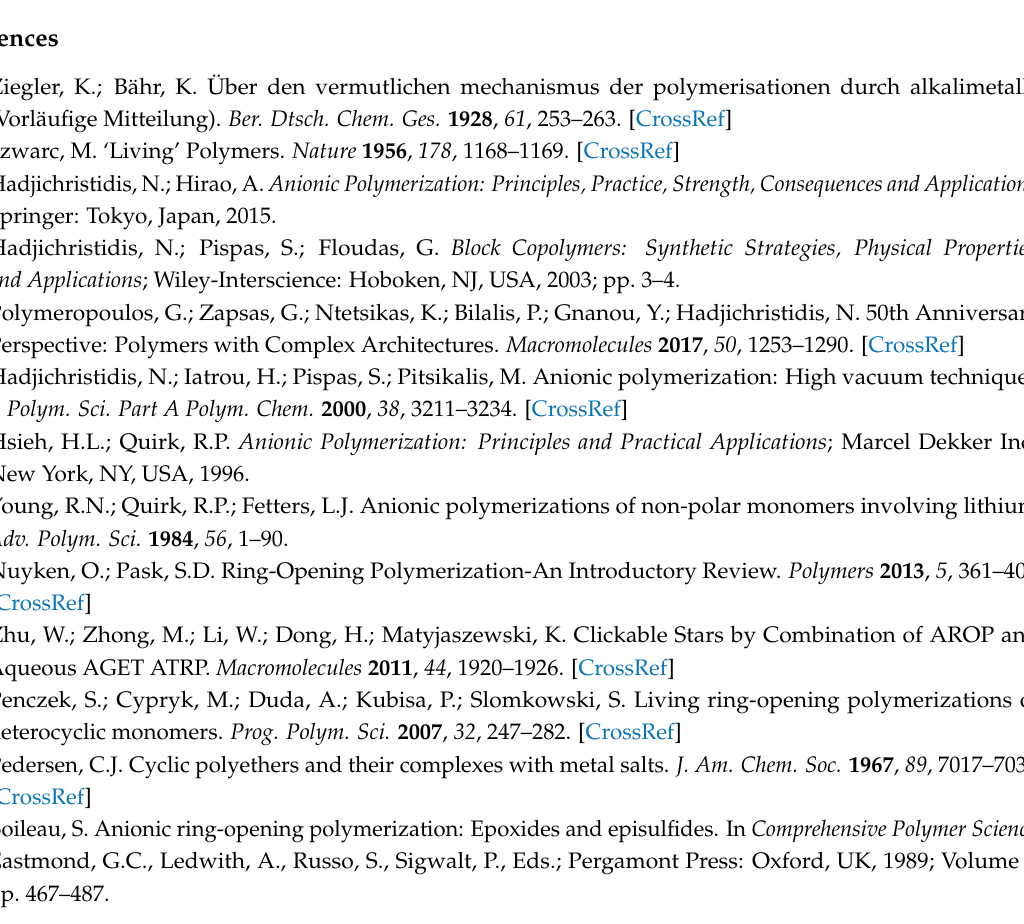
Figure S1: SEC traces obtained from withdrawn aliquots at 10 min and 20 min {[ t -BuP 4 ]/[ sec -BuLi]:1/1, styrene}; Figure S2: 1 H-NMR spectra after 30 min, 2 h and 4 h (100% conversion) {[ t -BuP 2 ]/[ sec -BuLi]:0.5/1, styrene}; Figure S3: SEC traces obtained from withdrawn aliquots during the polymerization of styrene with [ t -BuP 2 ]/[ sec -BuLi]:0.5/1; Figure S4: SEC traces obtained from withdrawn aliquots during the polymerization